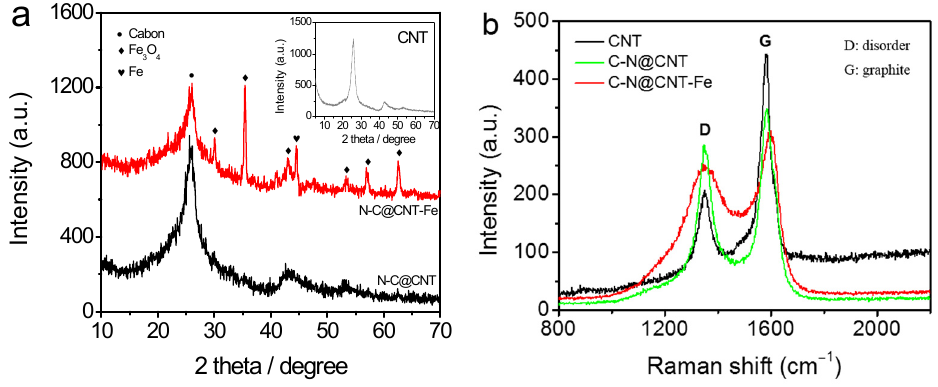
Figure 1. XRD patterns ( a ) and Raman spectra ( b ) of CNT, N-C@CNT, and N-C@CNT-Fe.